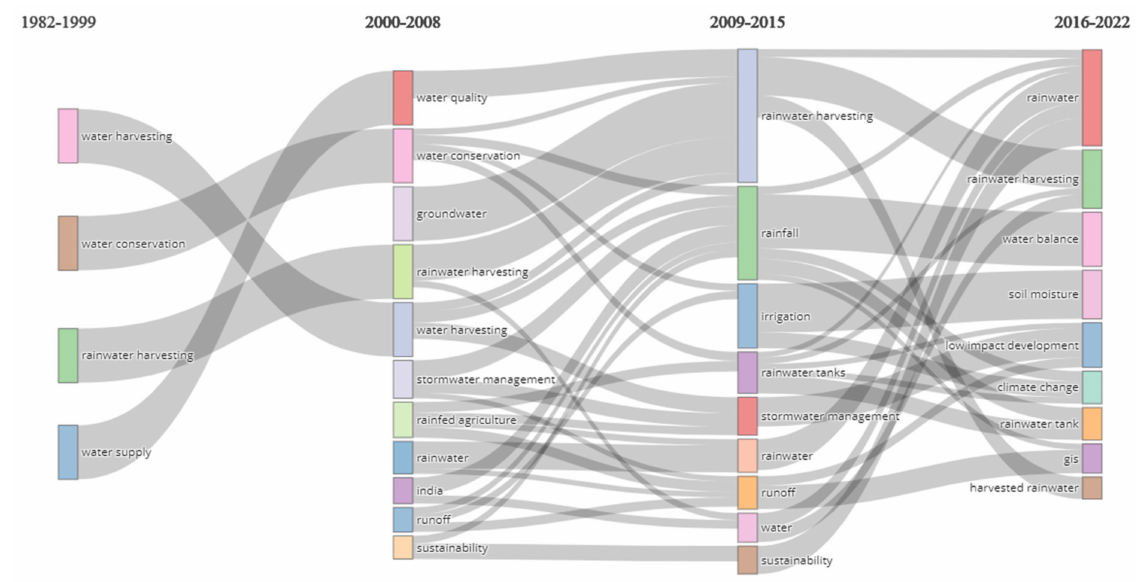
Figure 5. Thematic evaluation of the author’s keywords